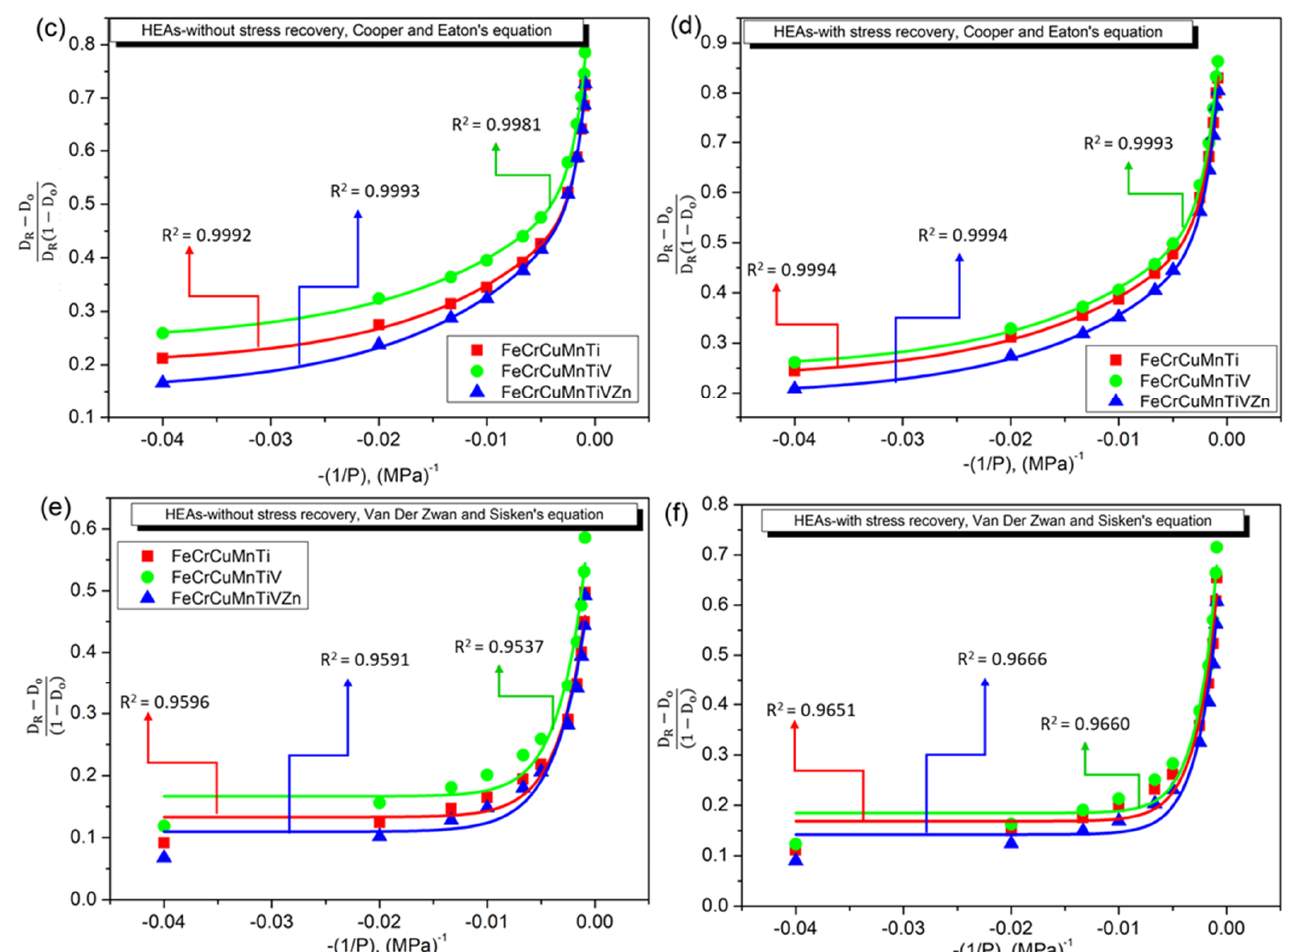
Figure 12. Densification behavior fitted by various non-linear models for the three developed nanostructured HEAs for as-milled and stress recovered conditions: ( a , b ) Shapiro’s Equation (11); ( c , d ) Cooper and Eaton’s Equation (12); ( e , f ) Van Der Zwan and Sisken’s Equation (13).